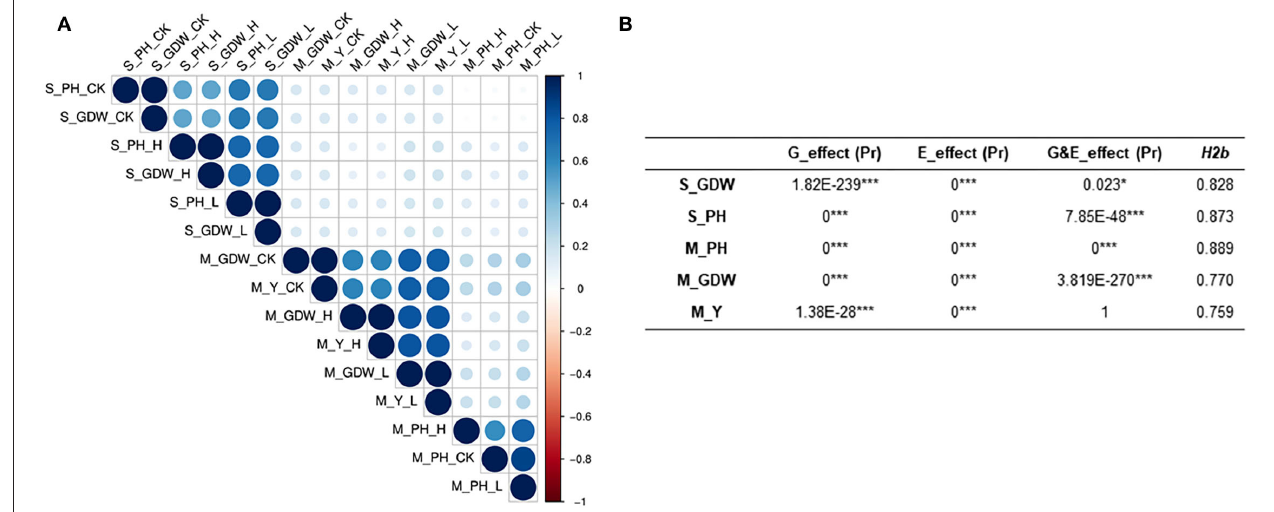
FIGURE 2 | Evaluation of correlation coefficient, heritability, and genetic and treatment effects of all traits under salt-alkali stress conditions at seedling and mature stages. (A) Heatmap showing Pearson’s correlations ( r ) among all traits of the 505 B. napus accessions assessed under control (CK, control condition, 0.1–0.25% salt content and pH 7.5–8.), low salt-alkali (L, low salt-alkali condition, 0.35–0.53% salt content, and pH 8–8.5), and high salt-alkali conditions (H, high salt-alkali condition, 0.64–1.05% salt content and pH 8.3–9.). S_GDW, ground dry weight and S_PH, plant height at the seedling stage. M_PH, plant height; M_GDW, ground dry weight; and M_Y, yield at the mature stage. (B) Broad-sense heritability, genetic and treatment effect analyses. H2b , broad-sense heritability; E_effect, treatment effect; G_effect, genetic effect; and G&E_effect, interaction of genetic and treatment effects. Statistical significance was evaluated by Student T -test. * p < 0.05 and *** p <